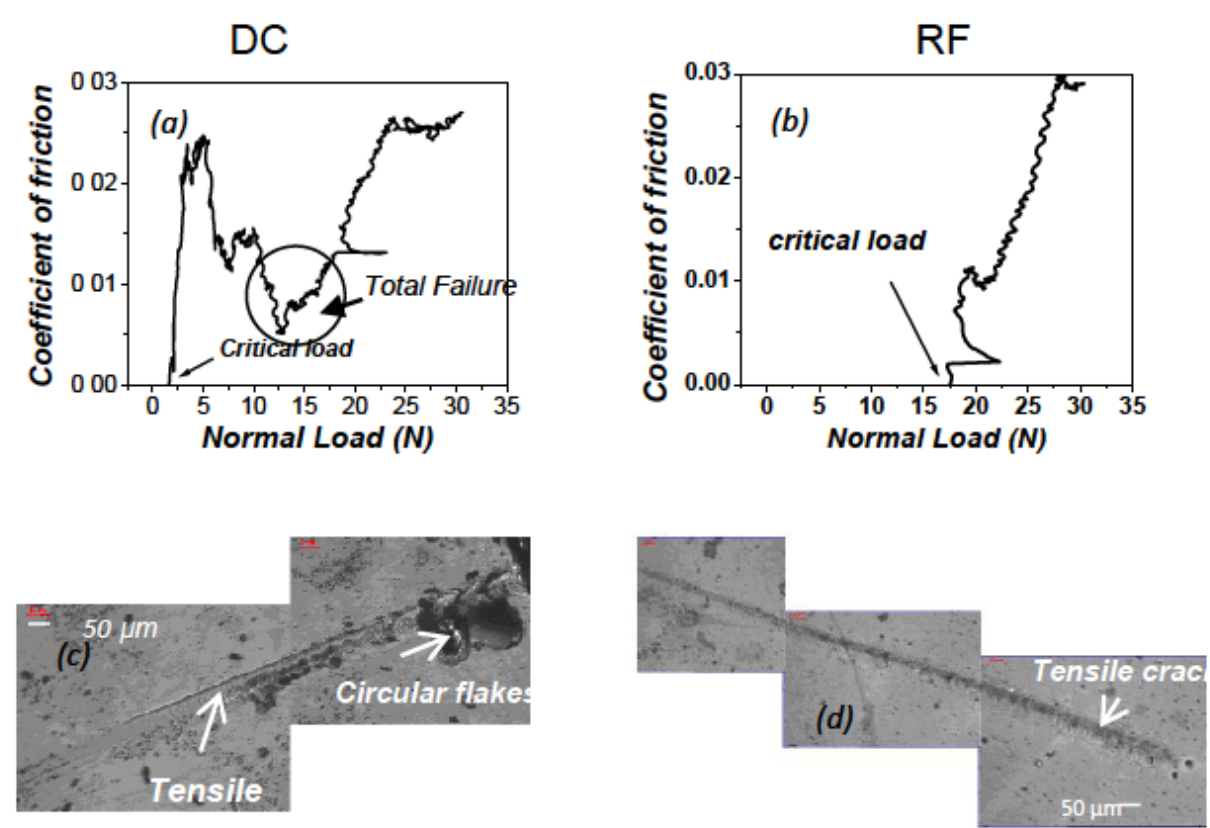
Figure 11: Coeflcient of friction vs. Normal load plots for Si-C-Films deposited in (a) DC and (b) RF modes and corresponding scratch tracks